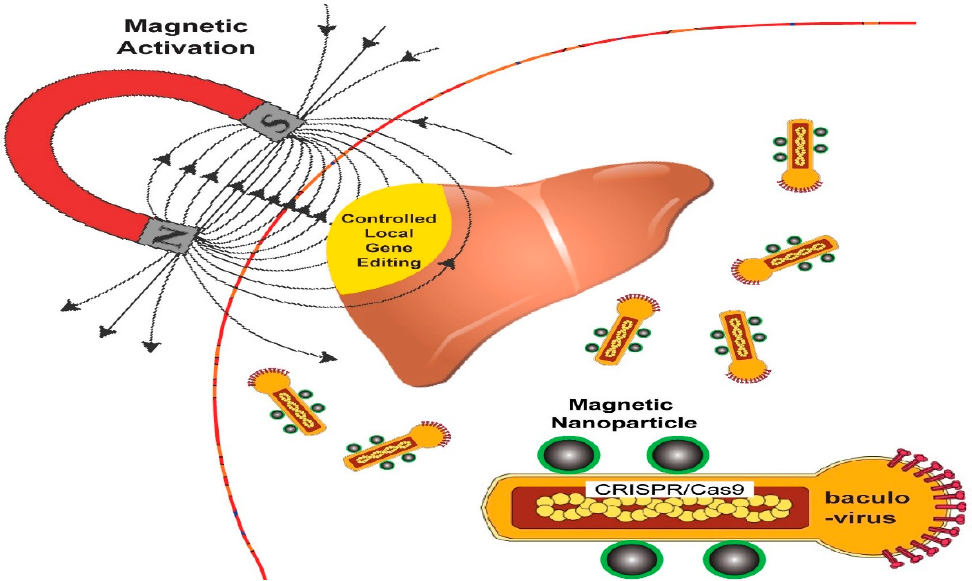
Figure 9. A schematic illustration of the MNP-BV system for in vivo delivery of CRISPR/Cas9 with magnetic. Reprinted with permission from ref [73]. Copyright 2018, Springer Nature.